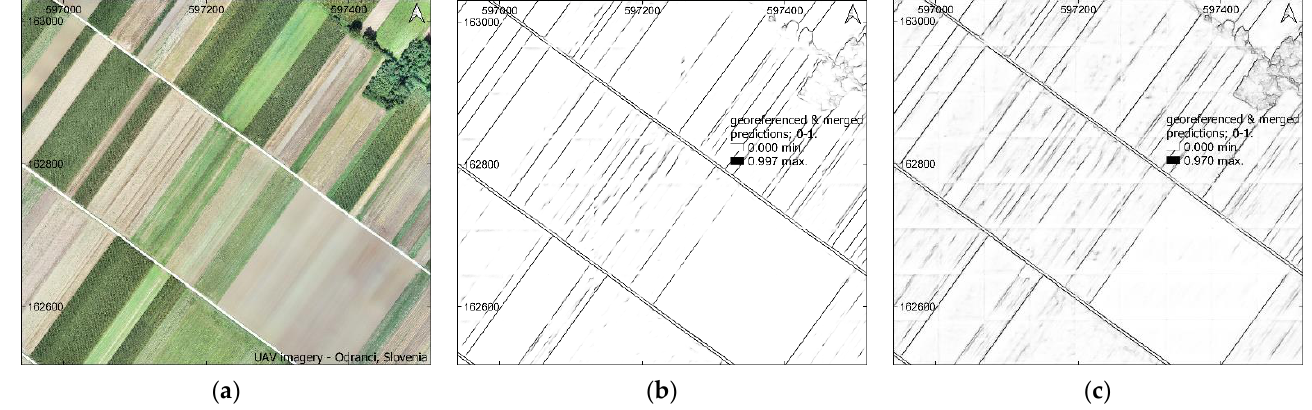
Figure 6. Georeferenced and merged boundary maps for the test area in ( a ) Odranci, Slovenia. Pre- dicted boundary map with ( b ) customised CNN, and ( c ) original U-Net architecture.